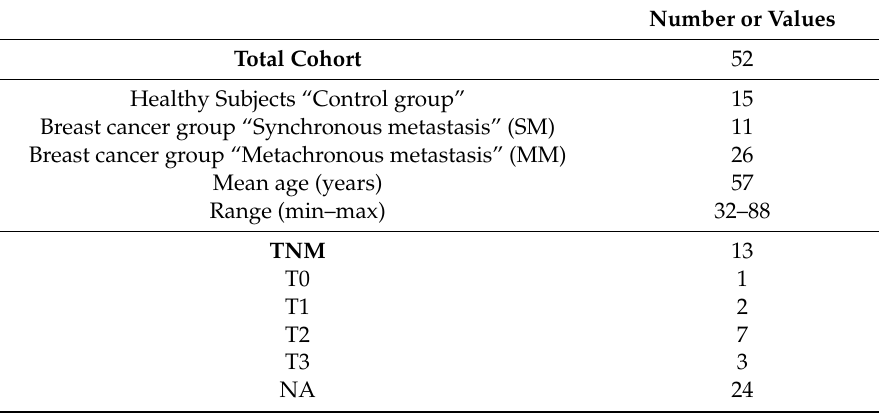
Table 1. Patient clinical-pathological